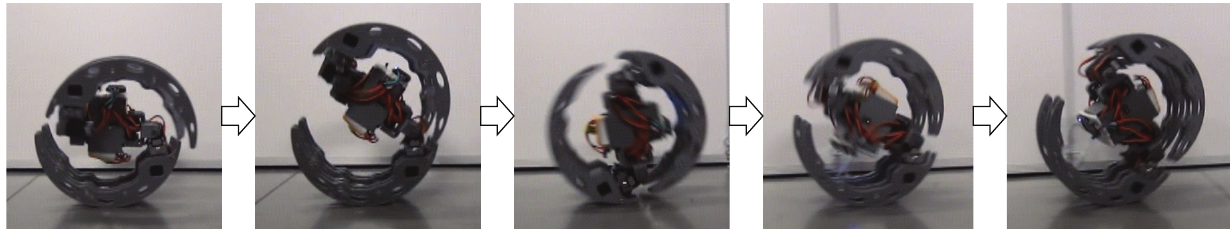
Figure 3: Rolling locomotion with feedforward control. The quadruped robot can roll on the flat ground by moving the front legs or the rear legs